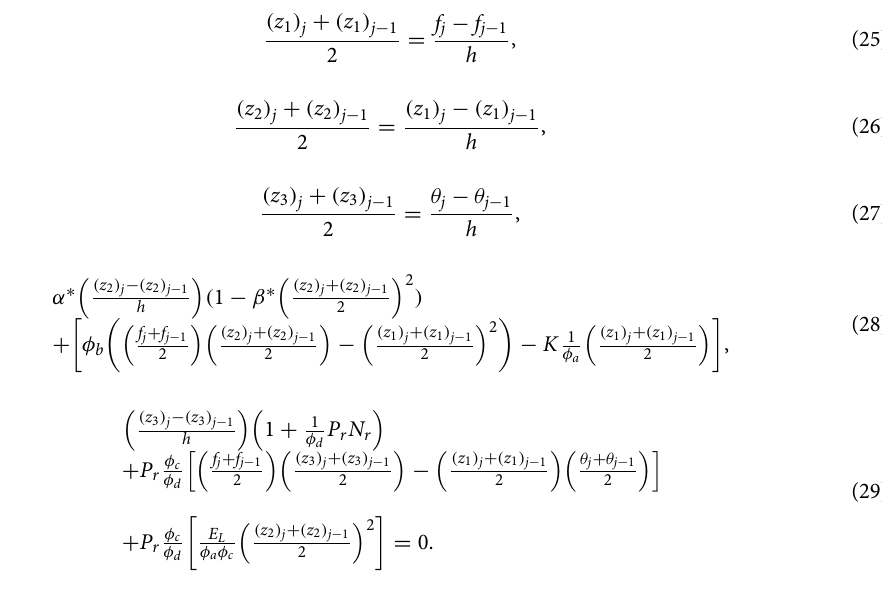
Stage 3: linearized formulas by Newton technique. The output formulas are reduced to linearity